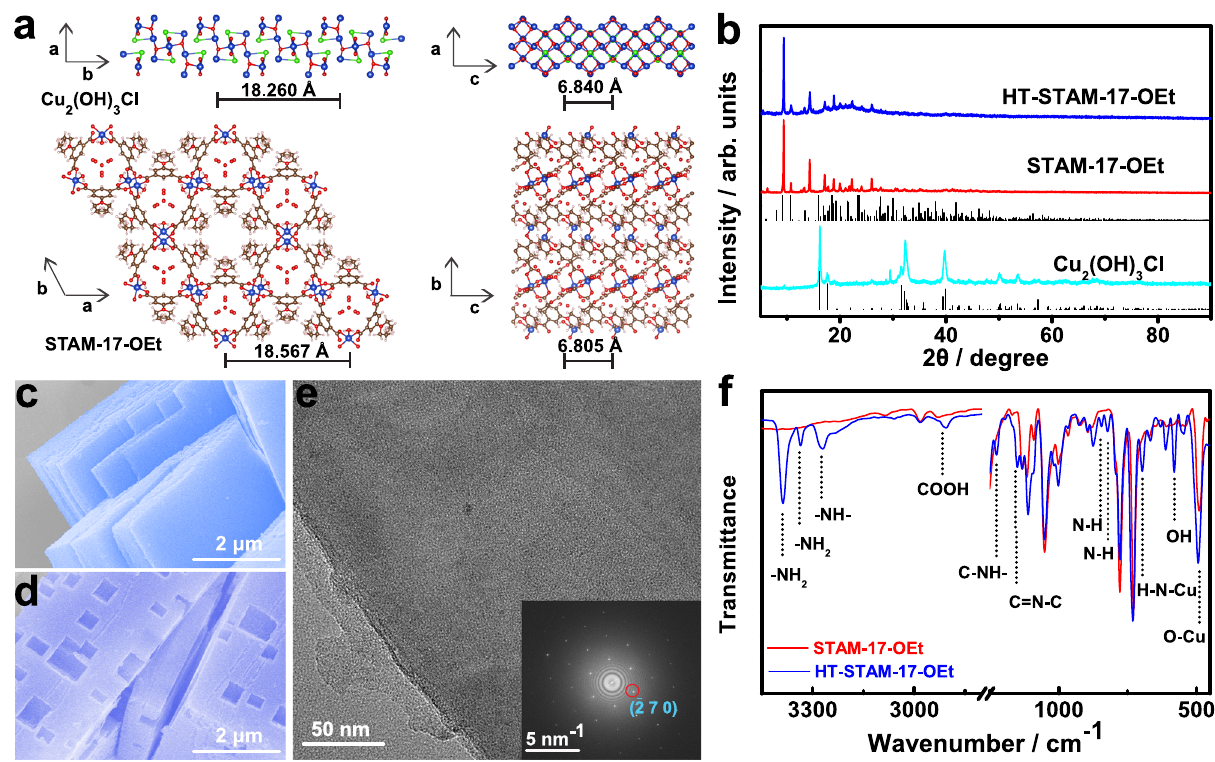
Fig. 2 | Structure characterizations of STAM-17-OEt and HT-STAM-17-OEt. a Crystal structures of Cu 2 (OH) 3 Cl and STAM-17-OEt. The blue, red, brown, green, and gray balls represent Cu, O, C, Cl, and H atoms, respectively. b XRD patterns of Cu 2 (OH) 3 Cl, STAM-17-OEt and HT-STAM-17-OEt. FESEM images of c STAM-17-OEt